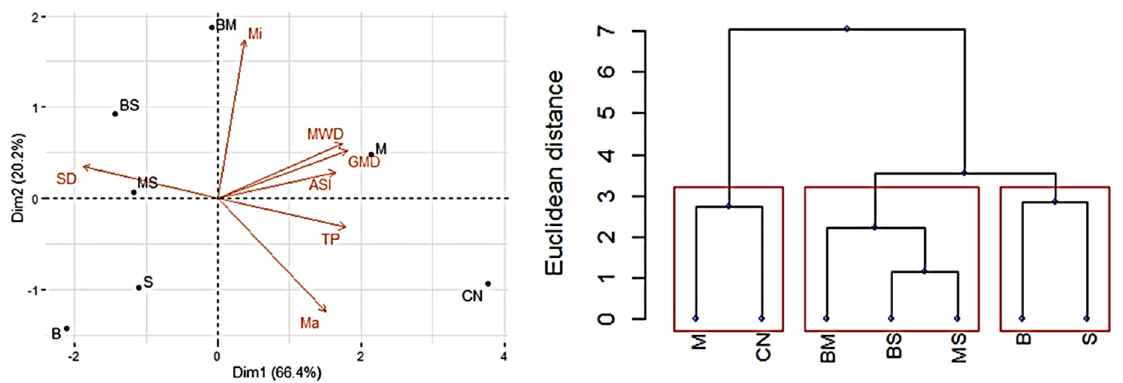
Figure 2. Principal components analysis, and cluster analysis of cover crops and Cerrado native area (CN) (0–0.1 m soil depth). B = Brachiaria, M = Pearl millet, S = Sunn hemp; BM = B + M; BS = B + S; MS = M + S; CN = Cerrado native forest. SD = soil bulk density; Ma = soil macroporosity; Mi = soil microporosity; TP = soil total porosity; MWD = mean weight diameter; GMD = geometric mean diameter; ASI = aggregate stability index.